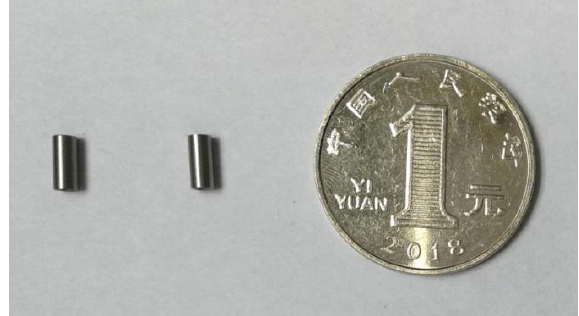
Figure 30. Microboosters.